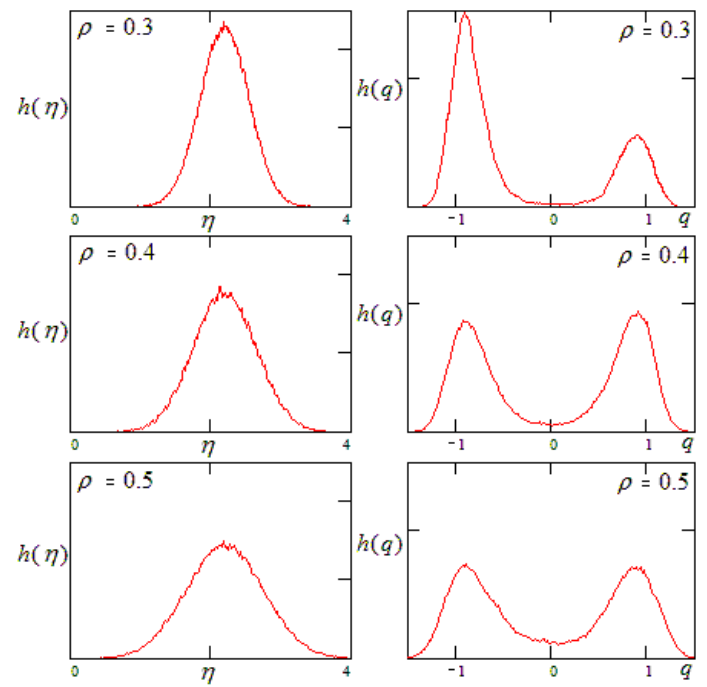
Figure 8: The distributions of the noise h ( η ) and of the order parameter h ( q ) for the noisy mean- field model in the multimer case.